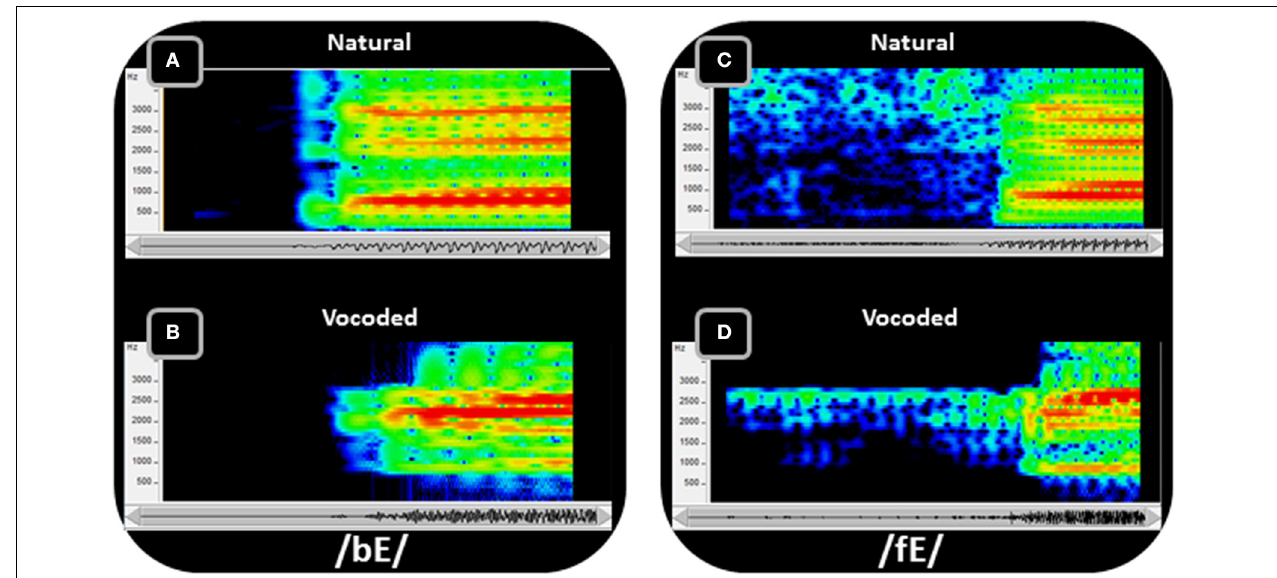
FIGURE 7 | Spectrograms of speech show the concentrations of energy in the spectra over time. Two speech tokens, /bE/ (A,B) and /fE/ (C,D) (i.e., the vowel in “bet”), are shown in spectrograms of the natural (A,C) recorded speech and the vocoded (B,D) speech. The frequency range of the spectrograms is limited to 4kHz, because all of the energy from the vocoder is similarly limited. The amplitudes are represented as a heat map, with red